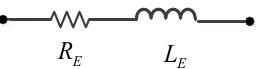
Figure 1. Section view of earphone.